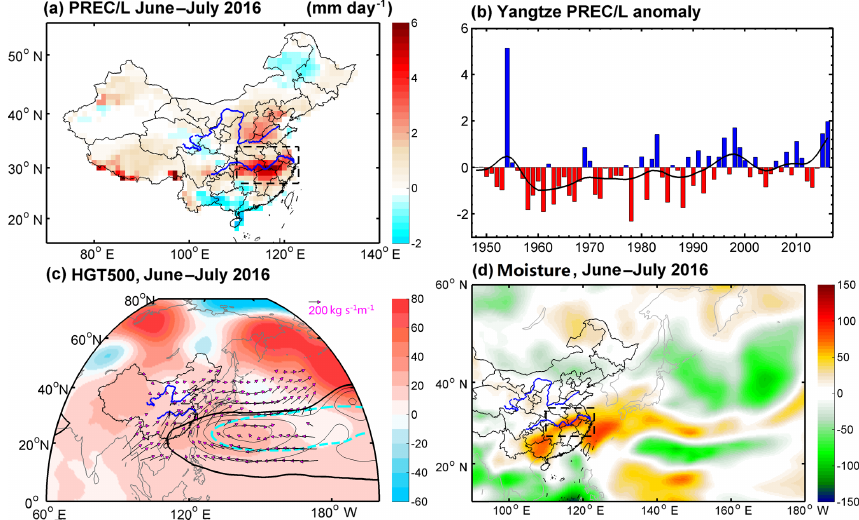
Figure 2. The 2016 extreme summer flood. (a) Mean precipitation anomaly (shading, mmday − 1 ) during June–July 2016. (b) Time series of the June–July mean precipitation anomaly averaged over the middle and lower reaches of the Yangtze River basin (110–123 ◦ E, 27– 34 ◦ N) in (a) . (c) Anomaly of 500hPa geopotential height (shading, gpm) superimposed by absolute integrated horizontal moisture transport between the 1000 and 300hPa layers (vectors, kgm − 1 s − 1 ) . The thick contour lines are 5880gpm, implying the location of the West Pacific Subtropical High, where the black denotes June–July 2016 and the cyan is the climatology during 1982–2010. (d) Anomaly of the integrated horizontal moisture transport amount (shading, kgm − 1 s − 1 )